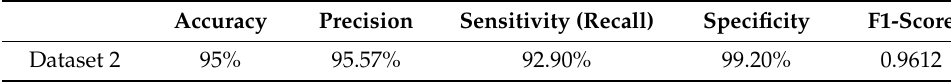
Table 8. The evaluation indicators tested on dataset 2.